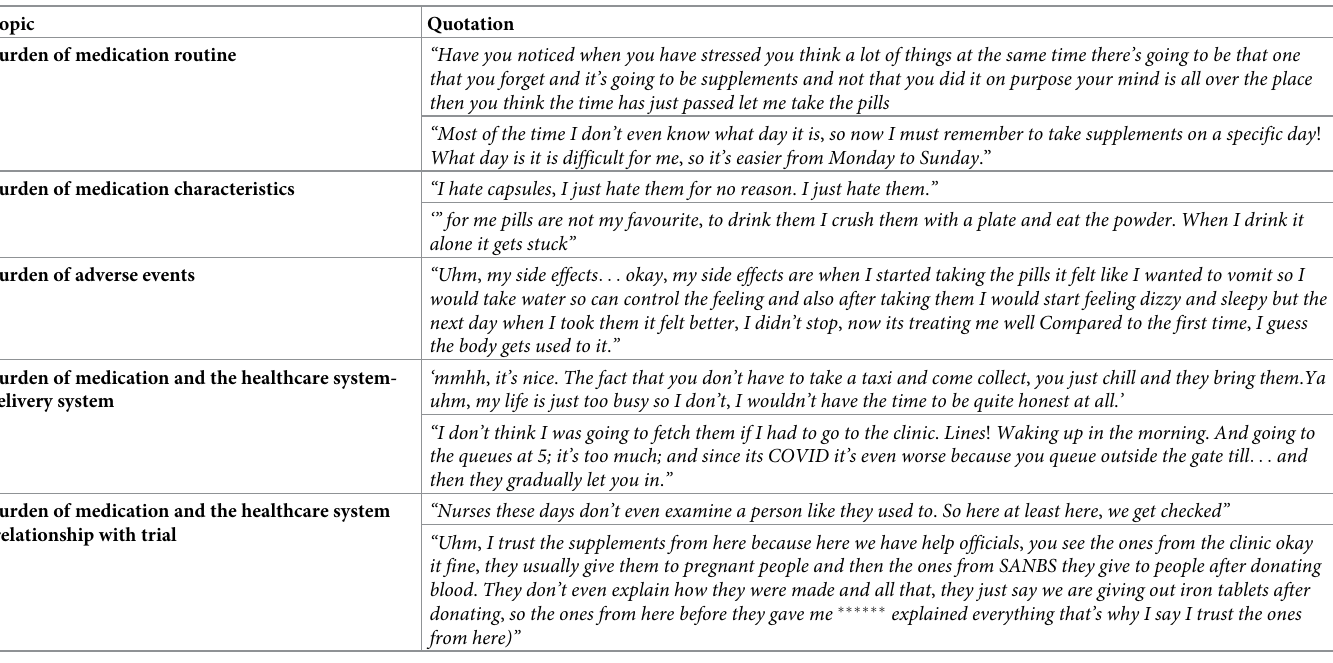
Table 4. Burden of medication related